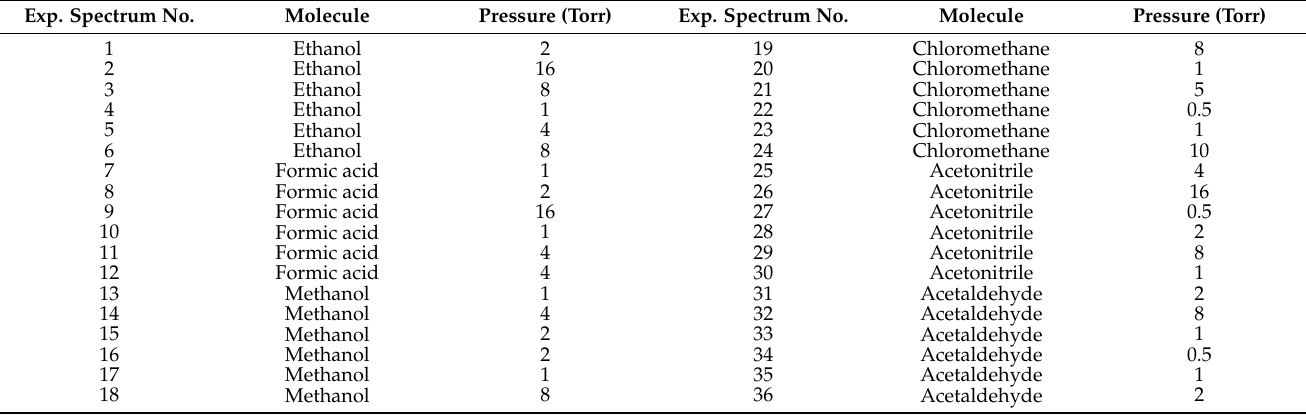
Table 3. Experiment conditions. The experimental spectra are sequentially plotted from left to right in Figures